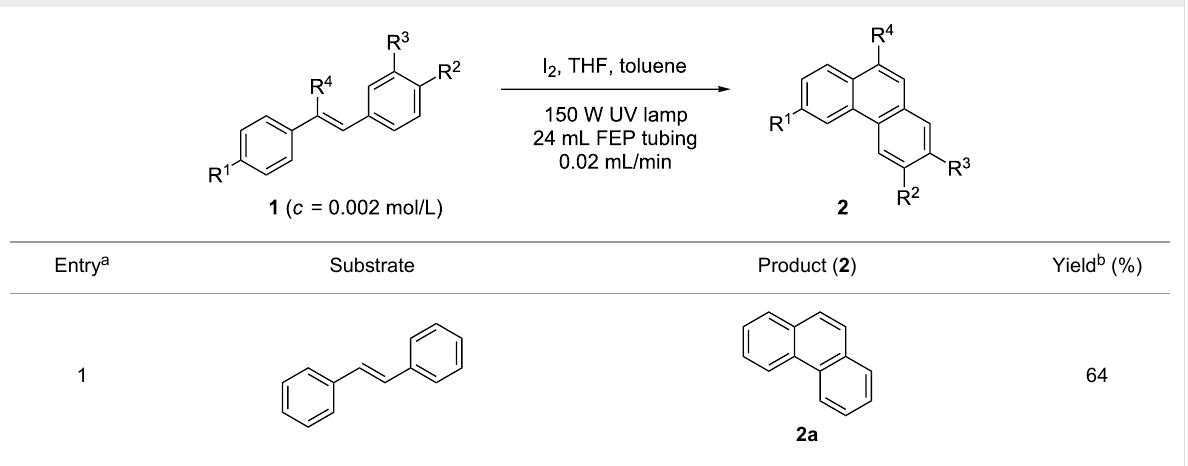
Table 3: Scope of the photocyclization of stilbene derivatives in continuous flow to give substituted phenanthrenes.